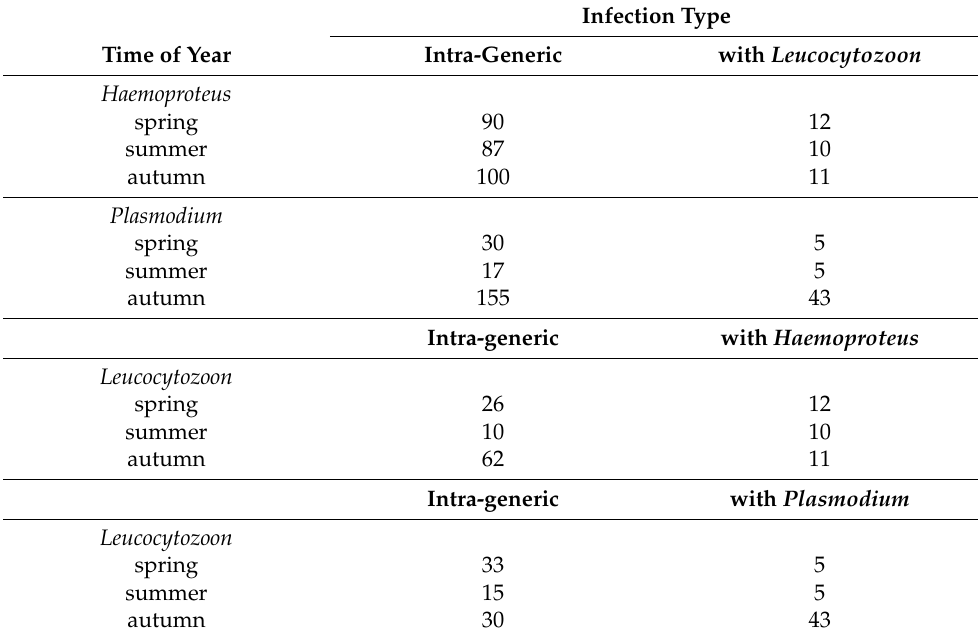
Table 4. Relationship between infection type, considering intra- vs. inter-generic infections, and time of year for the frequency of haemosporidian cytochrome b lineages detected in Drienovec, Slovakia, during 2017, 2018 and 2019. Note that haemosporidian lineage identity was not known for all parasites involved in multiple infections.